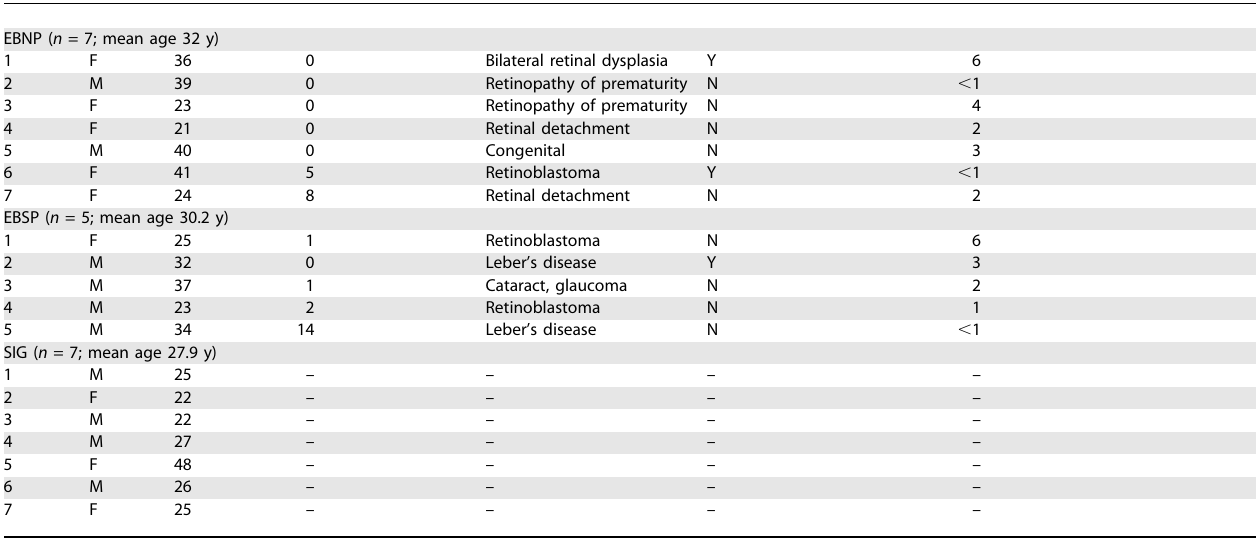
Table 2. Characteristics of Blind and Sighted